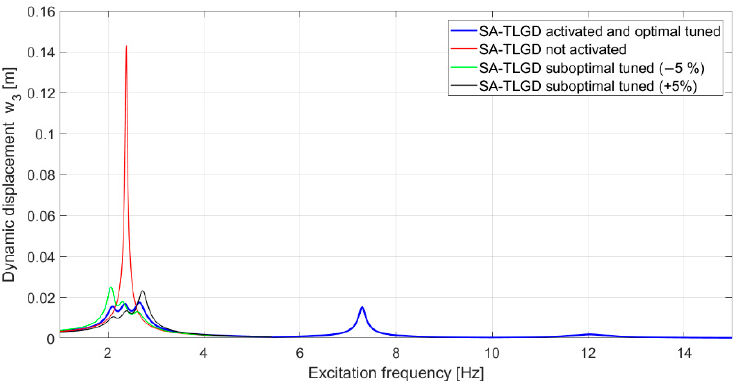
Figure 10. Frequency response functions (FRF) of the force excited MDOF-shear frame structure with two sub-optimal tuned SA-TLGDs in parallel connection (steady state response of floor displacement w 3 ; frequency shift of the fundamental natural frequency f S 1 = 2.38 Hz to 𝑓 (cid:3020)(cid:2869)(cid:2878)(cid:2873)% = 2.50 Hz and 𝑓 (cid:3020)(cid:2869)(cid:2879)(cid:2873)% = 2.26 Hz assumed).